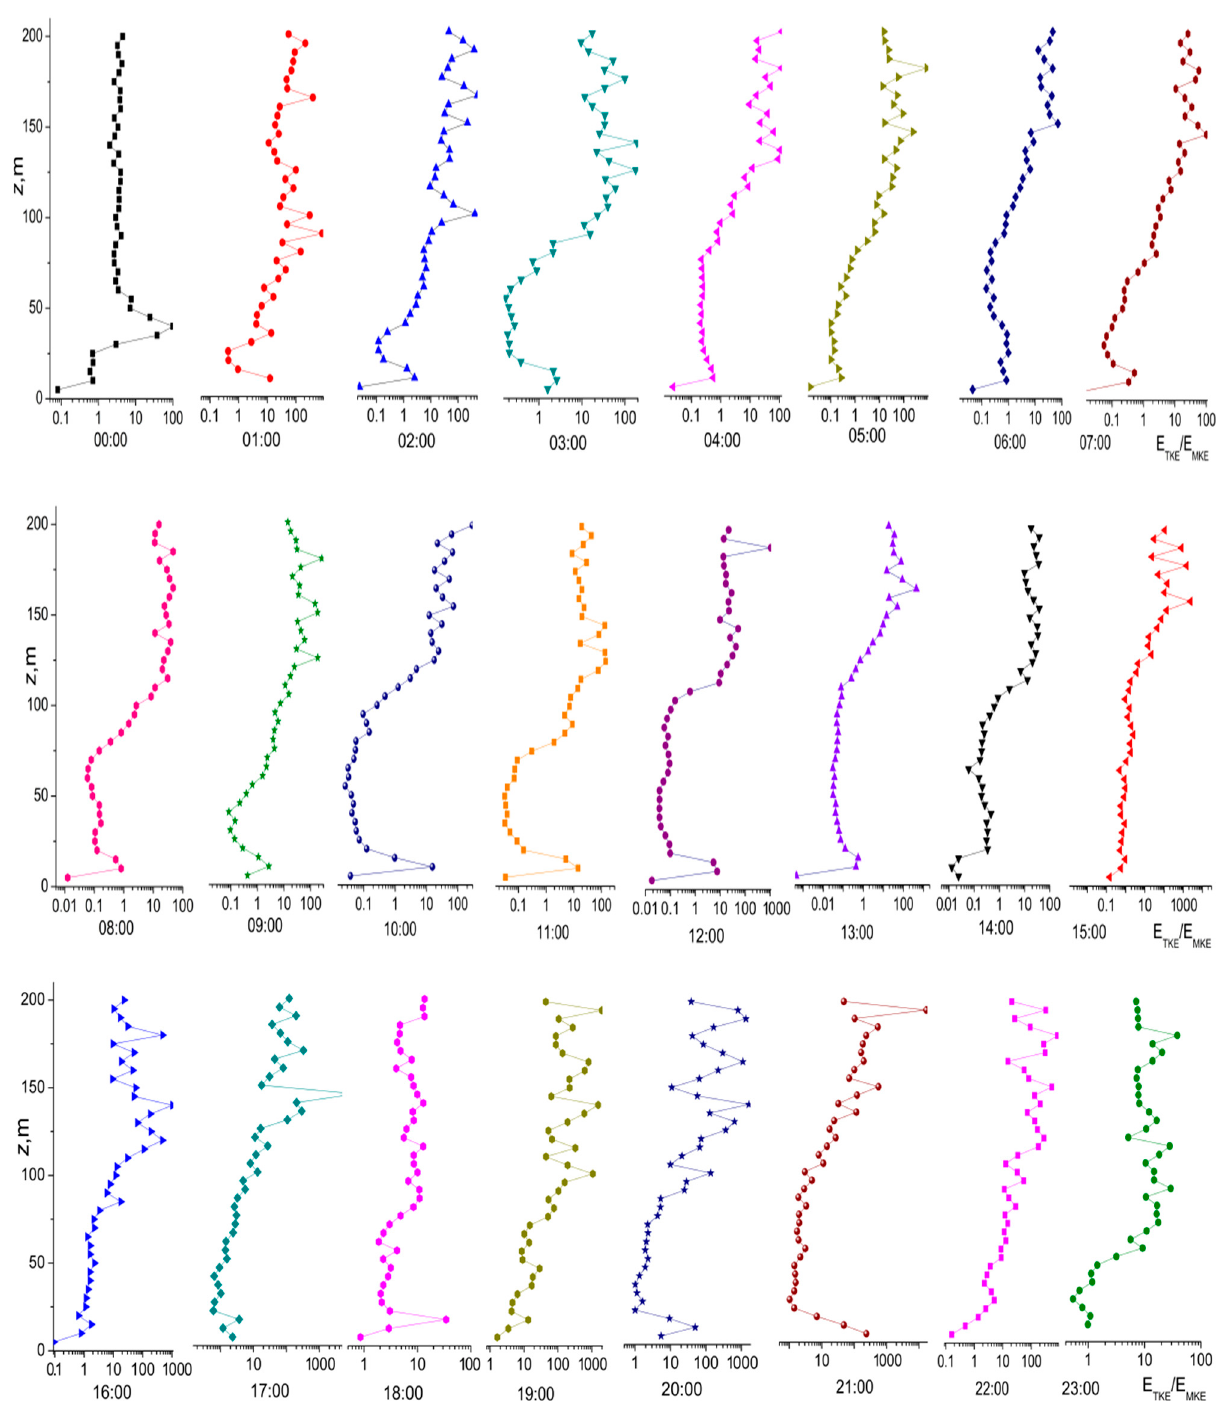
Figure 3. Diurnal hourly dynamics of the ratio of the turbulent to the mean kinetic wind energy components on semi-logarithmic scale.